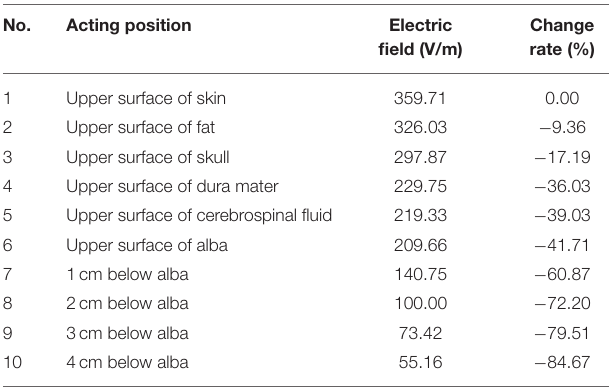
TABLE 3 | Distribution of induced electric field of rTMS coil in the layered model of brain.